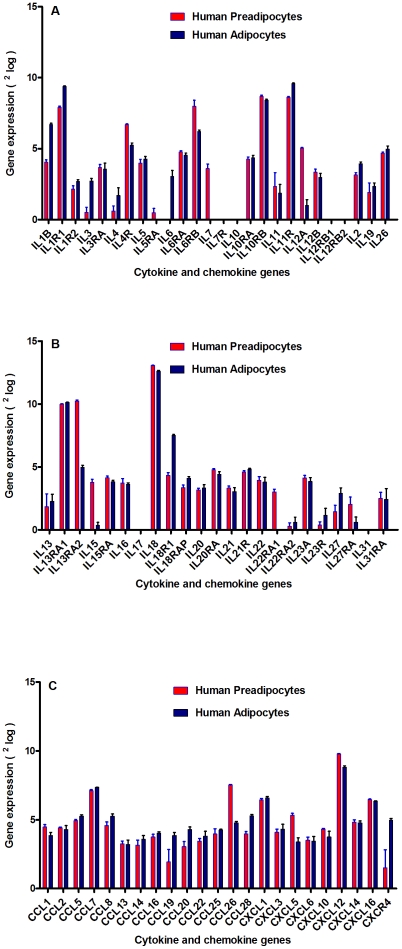
The expression of immune-associated components (cytokine and chemokine genes) by human primary adipocytes.Figure 4 A–C shows cytokines and chemokines and their receptor gene expression by human adipocytes, using Illumine BeadArray. Illumina gene profiling analysis shows the expression of cytokines and chemokines in human pre- adipocytes (red bars) and adipocytes (blue bars). Gene expression was expressed as 2log and is shown on the y-axis. Illumina results were derived from two independent experiments. Each experiment was done in duplicate.